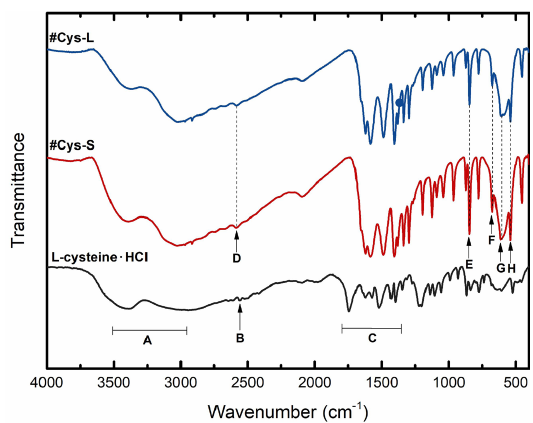
Figure 3. FTIR spectra of the pure commercial L-cysteine hydrochloride monohydrate and nanopowder